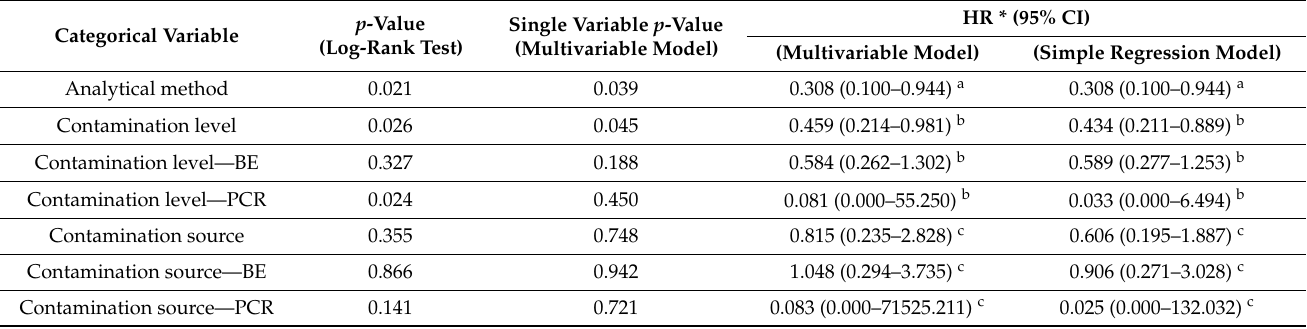
Table 7. Main results of statistical tests concerning the evaluated parameters and involving data from the whole dataset from the first, second and third experimental batches, and data separated according to the two different analytical techniques. p -Value Single Variable p -Value Categorical Variable (Log-Rank Test) (Multivariable